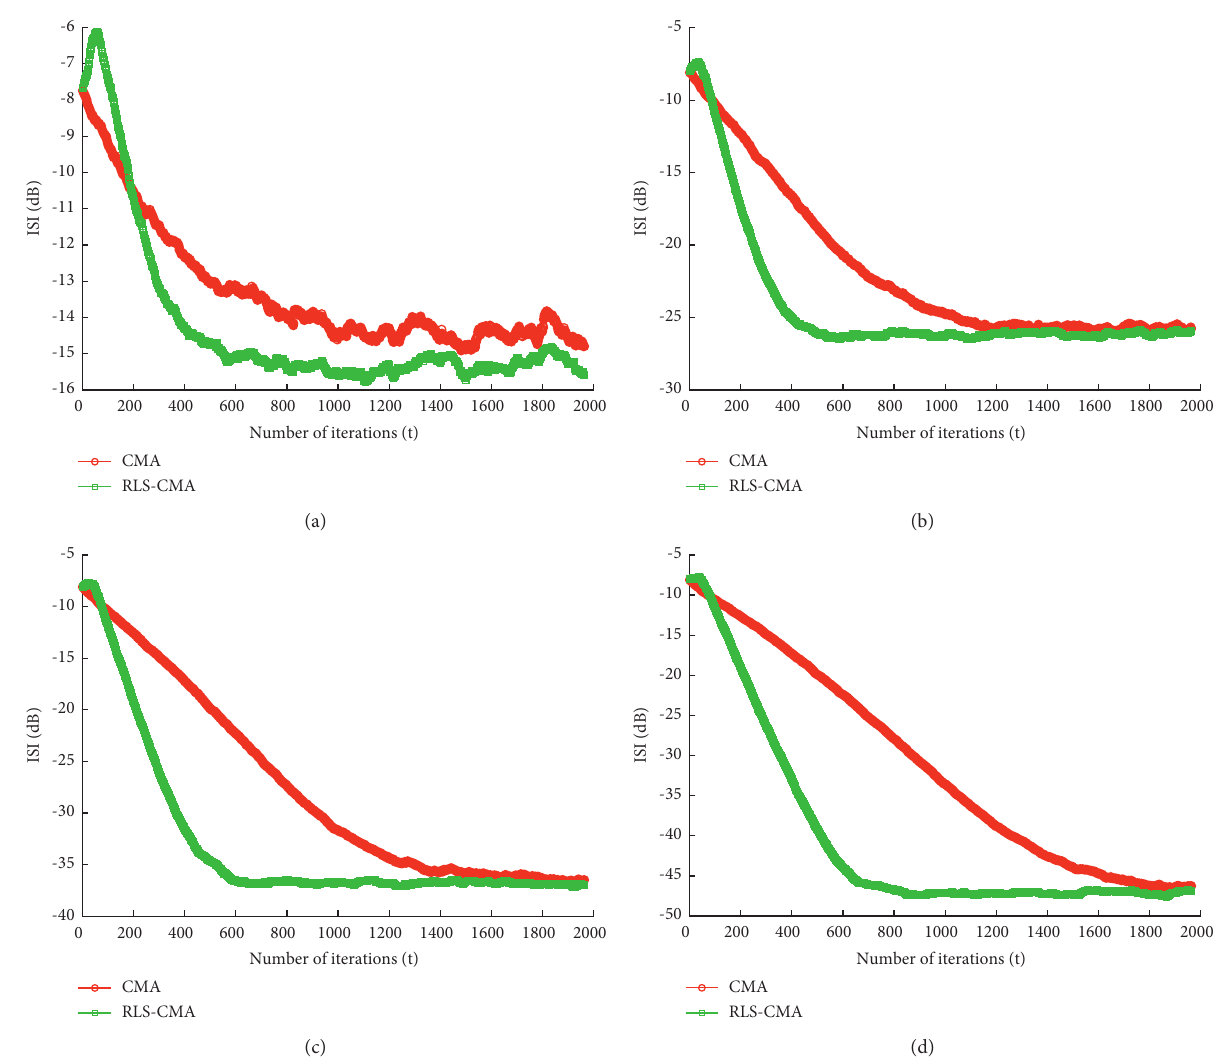
Figure 9: Relationships between the number of iterations and the ISI of the 16PSK-modulated signal obtained for different blind equalisation algorithms at SNR � 15–45dB: (a) SNR � 15dB. (b) SNR � 25dB. (c) SNR � 35 dB. (d) SNR � 45dB.